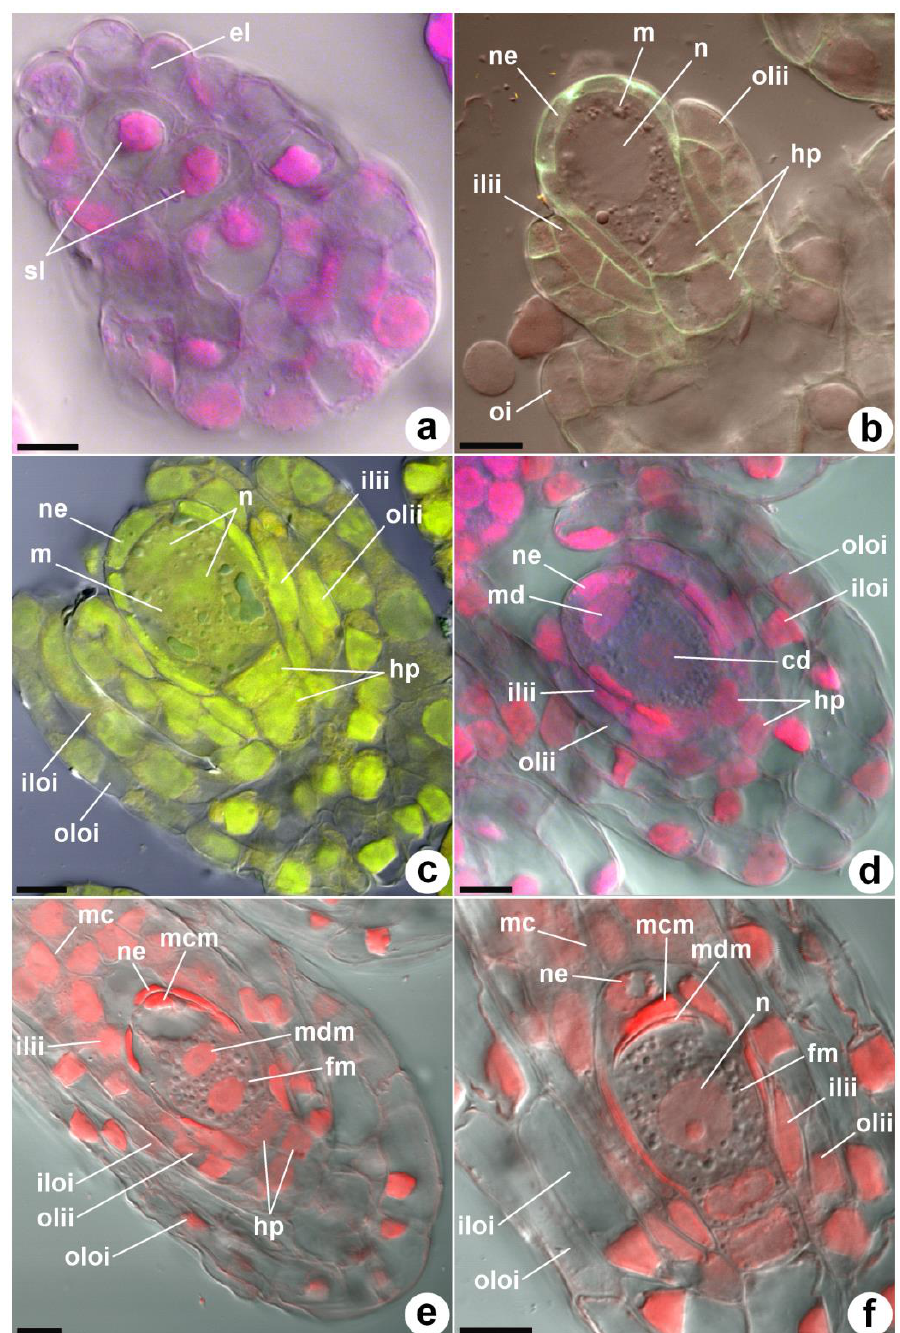
Figure 1. Megasporogenesis of C. speciosa subsp. fimbriata : used confocal laser scanning microscopy ( a ) Axial row of cells (PI); ( b ) Maternal megaspore and the beginning of the inner integument development (CF); ( c ) First division of the maternal megaspore (BRB); ( d ) Megaspore dyad (PI); ( e ) Second meiotic division of the chalazal dyad (PI); ( f ) Functional megaspore (PI). Abbreviations: cd, chalazal dyad; hp, hypostase; el, epidermal layer; fm, functional megaspore; ilii, inner layer of inner integument; iloi, inner layer of outer integument; m, megaspore mother cell; mc, micropyle; mcm, micropylar megaspore; md, micropylar dyad; mdm, middle megaspore; n, nucleus; ne, nucellar epidermis; olii, outer layer of inner integument; oi, outer integument; oloi, outer layer of outer integument; sl, subepidermal layer. Scale bars = 10 µ